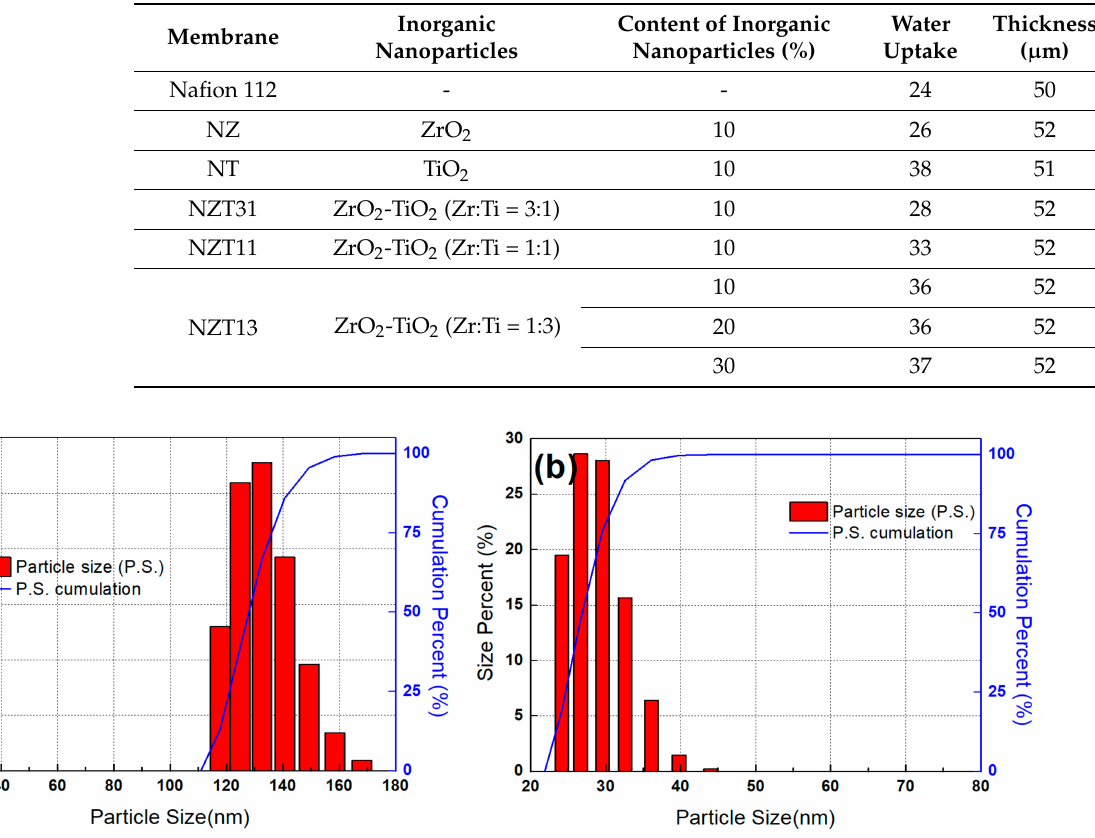
Figure 1. Particle size distribution of ZrO 2 -TiO 2 ( a ) before and ( b ) after ball milling. The cross-section of the Nafion and NZT13 (Zr:Ti = 1:3) membrane was analyzed using FE-SEM at the same magnifications. Figure 2a,b illustrates a cross-section image of the Nafion electrolyte membrane and of the composite electrolyte membrane NZT13, which were magnified by 5000 times. No white particles were observed in the images (a) of the Nafion membrane. However, in the case of NZT13, the synthesized inorganic nanoparticles were clearly shown as white spots and these spots were evenly distributed in the Nafion matrix. The cross-sectional images of the pristine Nafion 112 presented almost straight linear lines. The linear lines are thought to be related to ‘-[CF 2 -CF 2 ] n -[CF 2 -CF] m -’ of the main PTFE chains in Nafion polymer composed of main chains, side chains, and sulfone end groups. Herein, the subscript “n, m” denotes the degree of polymerization, that is, the number of units linked together. However, the images of the composite membrane showed highly branched lines. The linear lines were transformed into a more complex network of cross-section lines by the inorganic filler. This may demonstrate that the composite polymers were more tortuous by containing the inorganic nanoparticles in the pristine